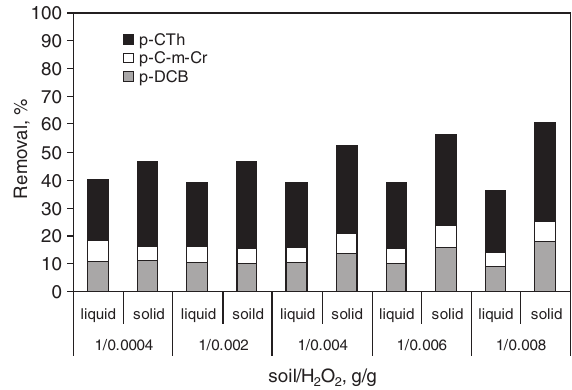
Fig. 1. p-DCB, p-C-m-Cr, and p-CTh removal (% of initial content) in the soil after a 24-h treatment with liquid hydrogen peroxide and percarbonate, without the addition of supplemental ferrous iron and utilising different weight ratios of soil to H 2 O